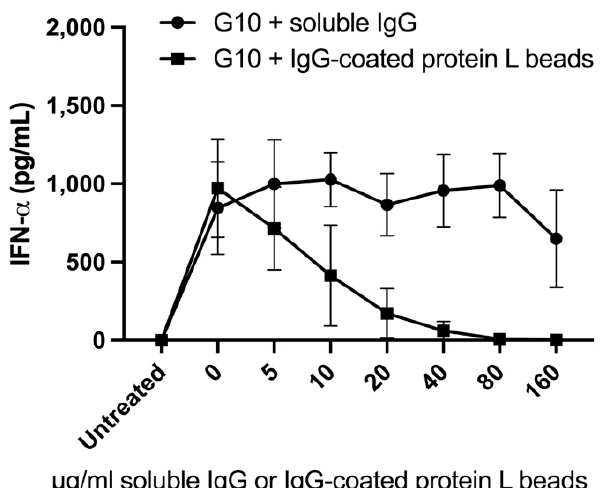
Figure 5. High concentrations of immune complexes inhibit G10-induced Type 1 Interferon pro- duction by PBMCs. Unfractionated PBMCs were treated with G10, a soluble TLR9 agonist plus various concentrations of soluble non-specific polyclonal IgG or IgG-coated protein L beads and supernatant was tested for IFN α by ELISA. Graphs depict means +/ − SEM. Statistical significance was determined using multiple paired T test with alpha = 0.05 ( n = 3). Statistically significant changes in IFN α levels occurred with the addition of 40, 80, and 160 μ g/mL of IgG-coated protein L beads (compared to cells treated with G10 alone).